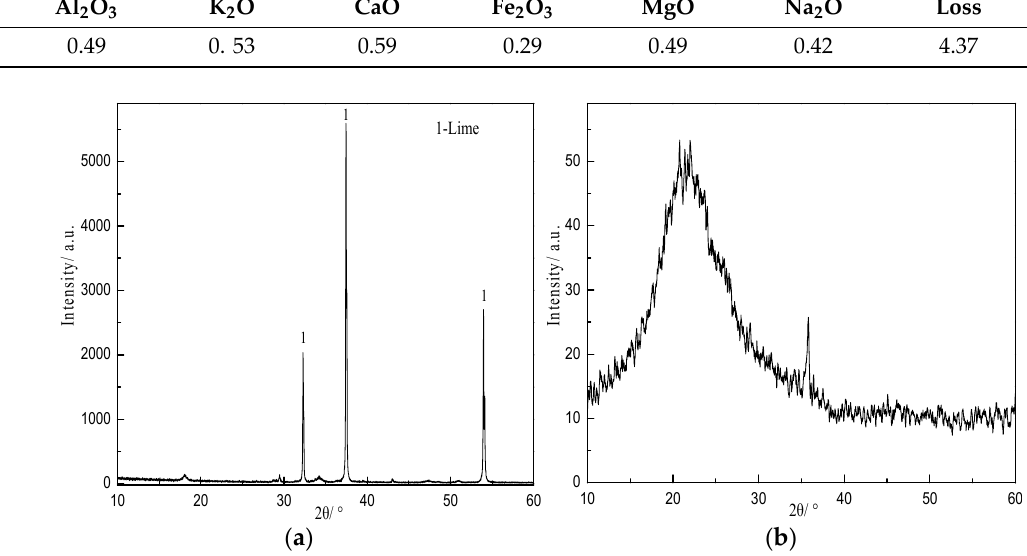
Figure 1. XRD patterns of calcium oxide ( a ) and silica fume ( b ).